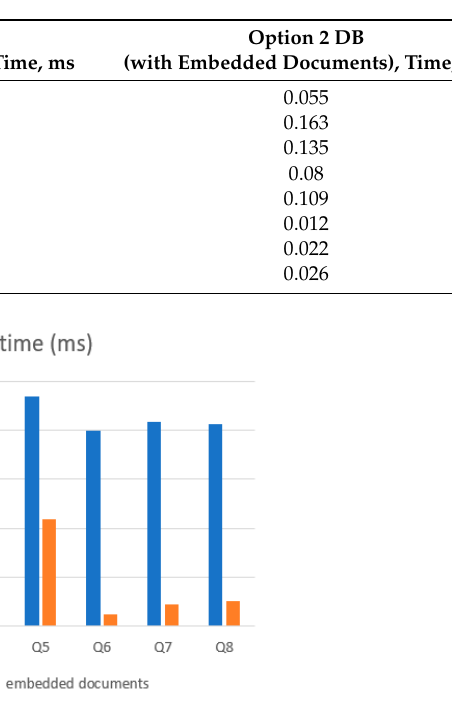
Table 3. The speed of execution of queries to document databases: without embedded documents and with embedded documents.